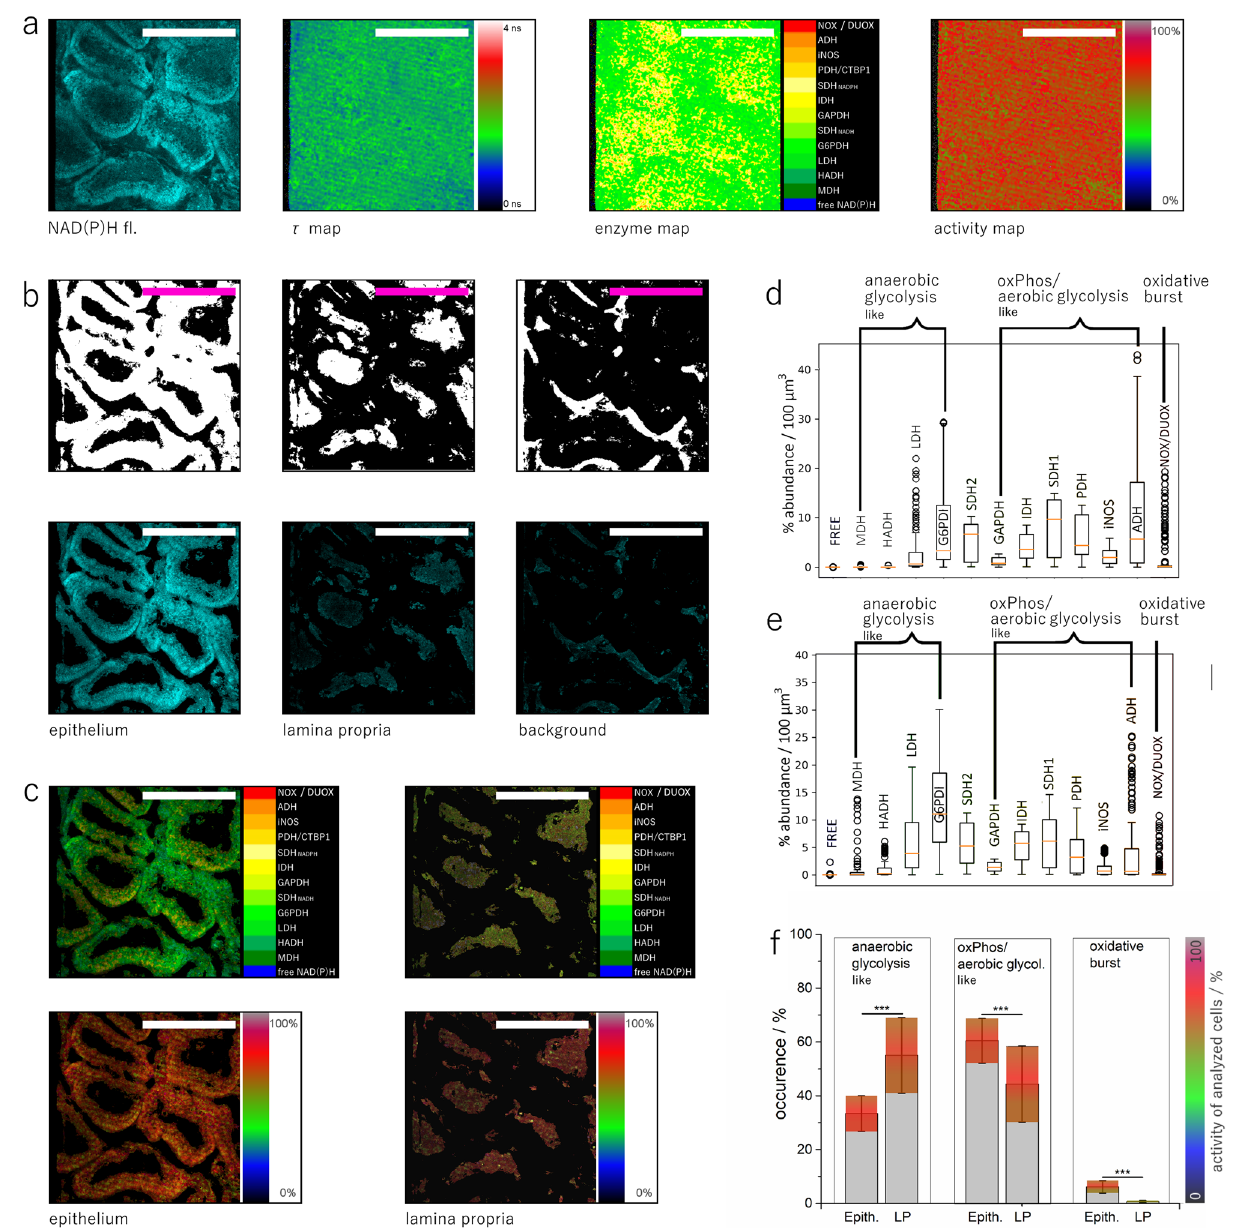
Figure 2. NAD(P)H fluorescence lifetime imaging of healthy explanted murine duodenum. (a) Representative NAD(P)H fluorescence sum image (500 × 500 × 100 µm 3 ), fluorescence lifetime image, enzyme map and activity map of healthy duodenum. (b) Segmentation of intestinal villi in epithelium and lamina propria using the same algorithm as described in Fig. 1. (c) Masked enzyme and activity maps for epithelium and lamina propria. (d) Frequency graph of preferential enzymatic activity in epithelium (data from n = 6 mice). (e) Frequency graph of enzymatic activity in lamina propria (data from n = 7 mice). Scale bar = 250 µm. (f) Pixel frequencies of anaerobic glycolysis-like, oxidative phosphorylation (oxPhos)/aerobic glycolysis-like pathways and oxidative burst, all given in percentage, for epithelial cells and lamina propria encompassing all mice in (d,e) . The superimposed false color bar for each column indicates the corresponding general metabolic activity per pixel, in percent. Statistical analysis in (f) was performed using ANOVA test (ns p > 0.05, *p < 0.05, **p < 0.01, ***p < 0.001). Figure generated with Paint.NET, https:// www. getpa int. net/ downl oad. Changes in metabolic activity in the intestinal villi during H. polygyrus infection. NAD(P)H fluorescence images of duodenum tissue from mice infected with H. polygyrus revealed a disorganization of the typical villi architecture in the vicinity of nematodes (Fig. 3a, Suppl. Fig. 4). Consequently, segmenting epithe- lium and lamina propria, as described for the healthy duodenum, was not always possible in the infected gut and we refer in all following data to intestinal tissue, without differentiating between epithelium and lamina propria.